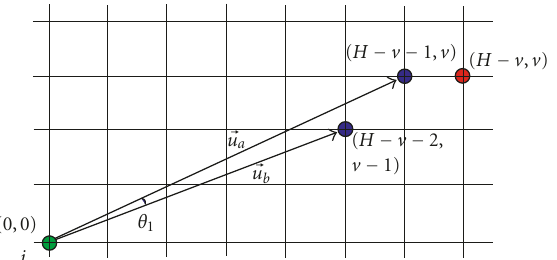
Figure 3: In order for the node ( H − v , v ) to be vwi to the source at the origin, the corresponding beam has to “clear” nodes ( H − v − 1, v ) and ( H − v − 2, v − 1). In this figure, H = 10 and v = 3 so that v < H/